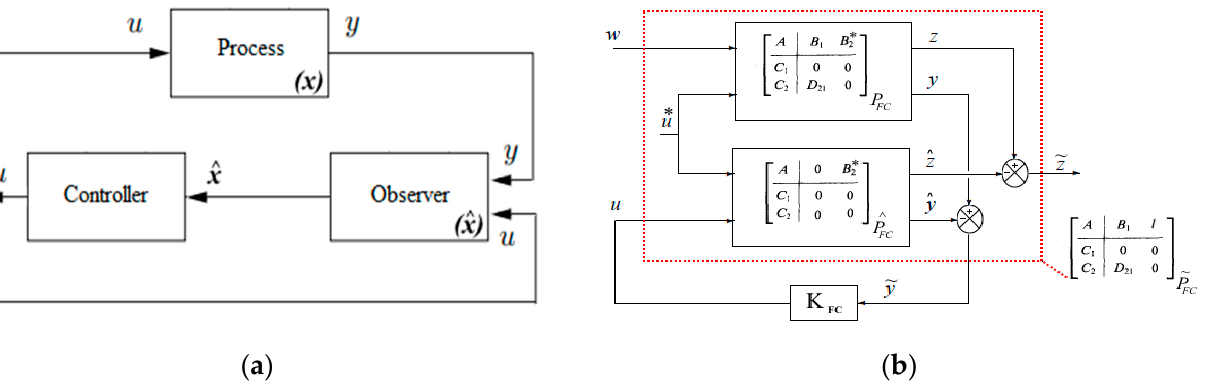
Figure 10. Observer-Based controller for rotary drilling system: ( a ) General Scheme, ( b ) H ∞ approach.